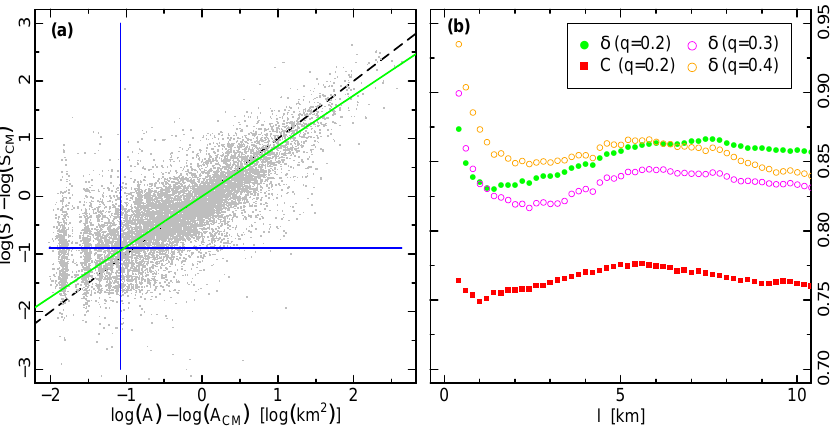
Figure 8. Correlations between area and population. ( a ) log ( S ) vs. log ( A ) for l = 0.4km and of all land cover clusters that could be matched with population figures (grey dots). The blue vertical and horizontal lines truncate the fraction q = 0.2 along both axis in order to avoid the discreteness at small A . The green solid line corresponds to the main axis around which the momentum of inertia of the truncated cloud is minimal. In this case, 8786 out of 12321 clusters remain. It’s slope δ is smaller than the diagonal (black dashed line, background); ( b ) Slope δ (circles) and Pearson correlation coefficients C (squares) vs. clustering parameter l for the cut-off q = 0.2 (green, red), q = 0.3 (magenta), q = 0.4 (orange). The exponent δ is found roughly between 0.82 and 0.87 except for small l where δ up to 0.87 and 0.93 are achieved but always below 1. For q = 0.2 the correlations exhibit a maximum around